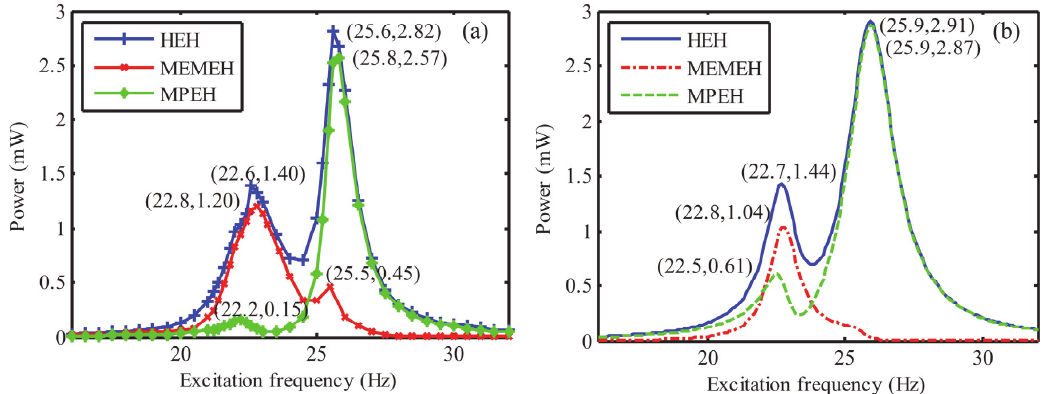
Figure 11. Frequency responses for the HEH, MEMEH, and MPEH: ( a ) experimental results; ( b ) numerical results.